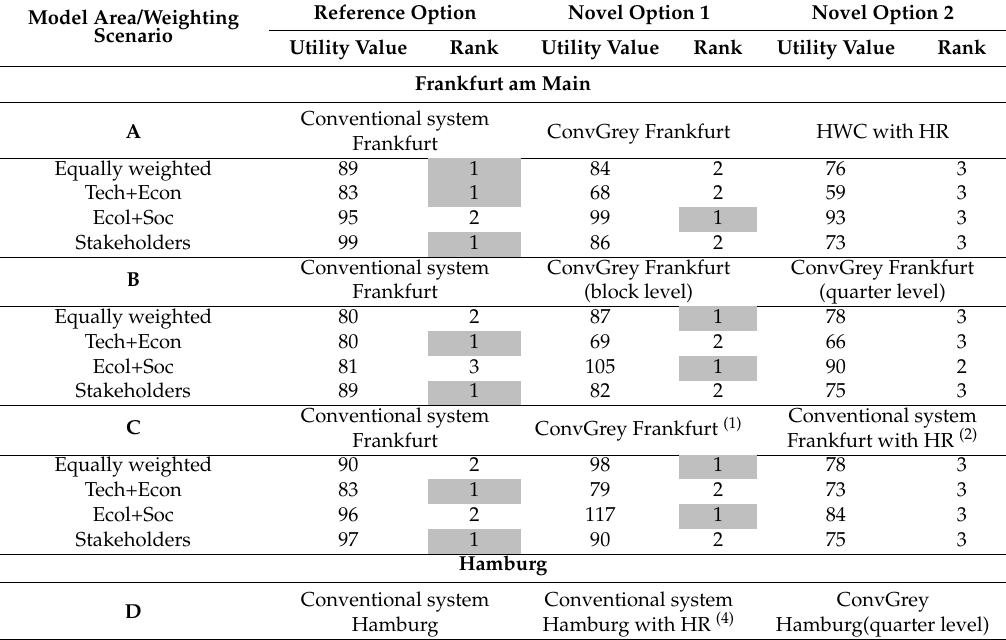
Table 4. Assessment results of water infrastructure options in the model areas (first ranks are